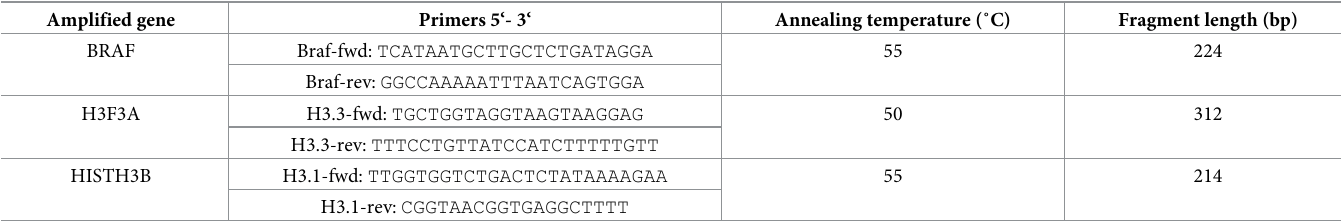
Table 1. Primers and PCR amplification